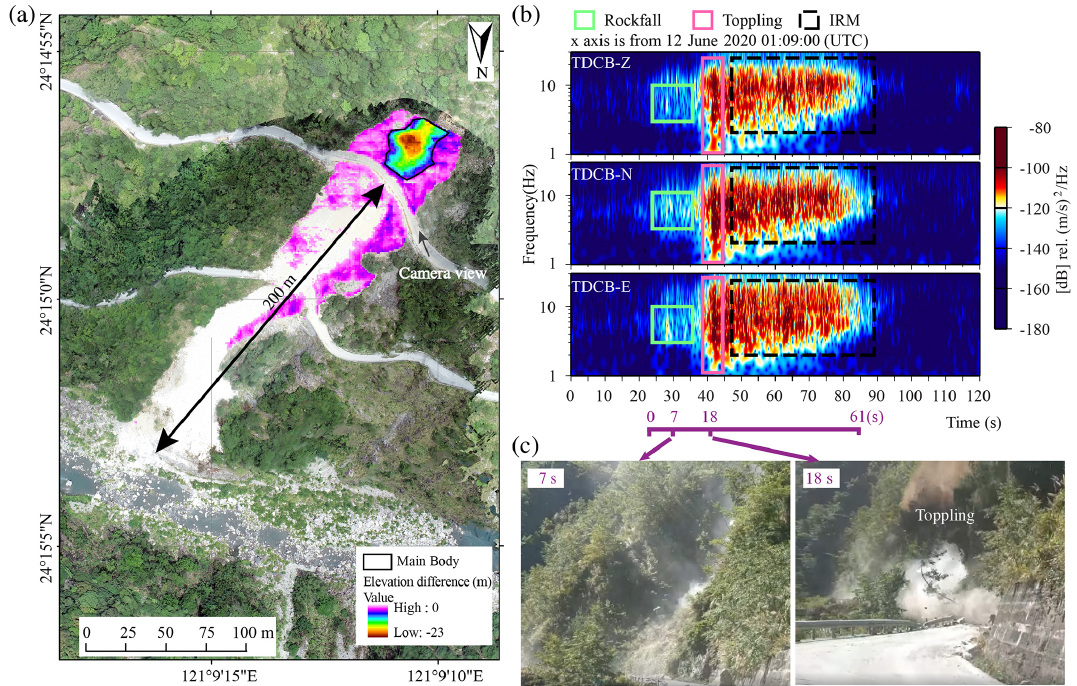
Figure 7. The field photo, spectrograms, and time-lapse photos from a video of a recent RSF on the 12 June 2020. (a) Field photo of the event. The gradient color is the elevation difference between the DTM originating from lidar in 2012 and the digital surface model (DSM) derived from a drone survey after the event. The main body is considered as the elevation difference larger than 3m. (b) The spectrograms of three components. The top-left corner of the spectrograms shows the station name with the components. The purple axis below the spectrograms indicates the time points from the video. (c) Time-lapse photos from the video corresponding to the physical process of rockfall (left panel) and toppling (right panel). The seconds shown in the top-left corner indicate a time tag in the